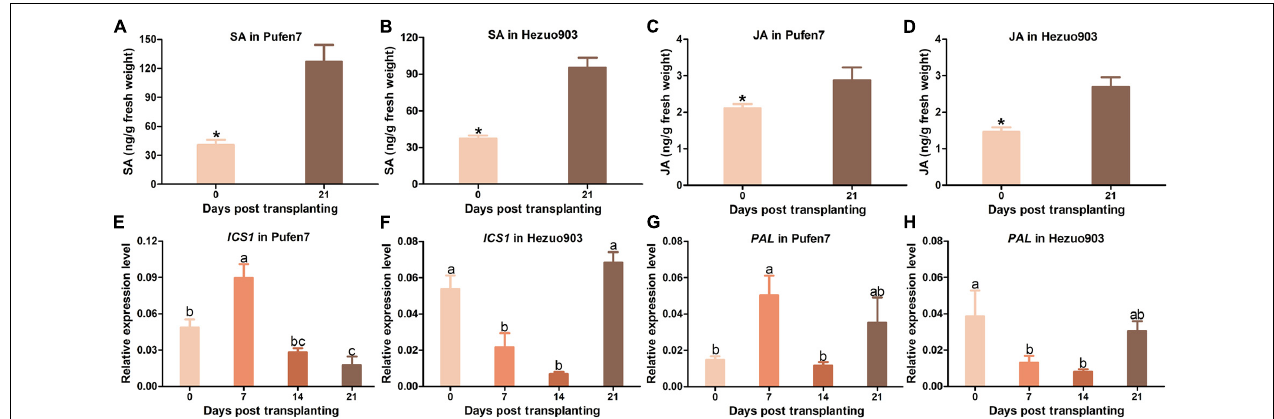
FIGURE 8 | Contents of salicylic acid (SA) and jasmonates (JA) and relative expression of SA biosynthesis genes in Pufen7 and Hezuo903 seedlings. (A) Contents of SA in Pufen7 seedlings of 0 and 21 DPT; (B) Contents of SA in Hezuo903 seedlings; (C) Contents of JA in Pufen7 seedlings; (D) Contents of JA in Hezuo903 seedlings; (E) Relative expression level of ICS1 in Pufen7 seedlings of 0, 7, 14, and 21 DPT; (F) Relative expression level of ICS1 in Hezuo903 seedlings; (G) Relative expression level of PAL in Pufen7 seedlings; (H) Relative expression level of PAL in Hezuo903 seedlings. Values are means ± SEM [ n = 4 for panels (A,B) ; n = 9–10 for panels (C,D) ; n = 6 for panels (E–H) ]. * above columns in panels (A–D) and different letters in panels (E–H) indicate significant differences among plants of different ages [independent t -test, p < 0.05 for panels (A–D) ; one-way ANOVA, p < 0.05 for panels (E–H) ].